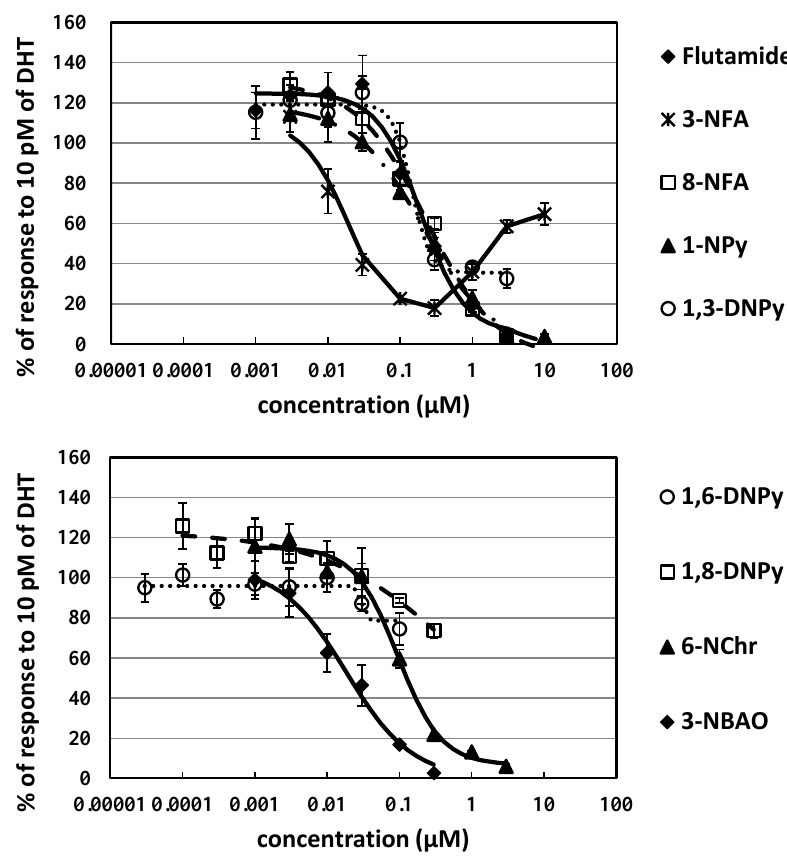
Figure 3. Dose–response curves of antiandrogenic activities for nitro-PAHs in 24 h exposure experi- ments with the AR-CALUX